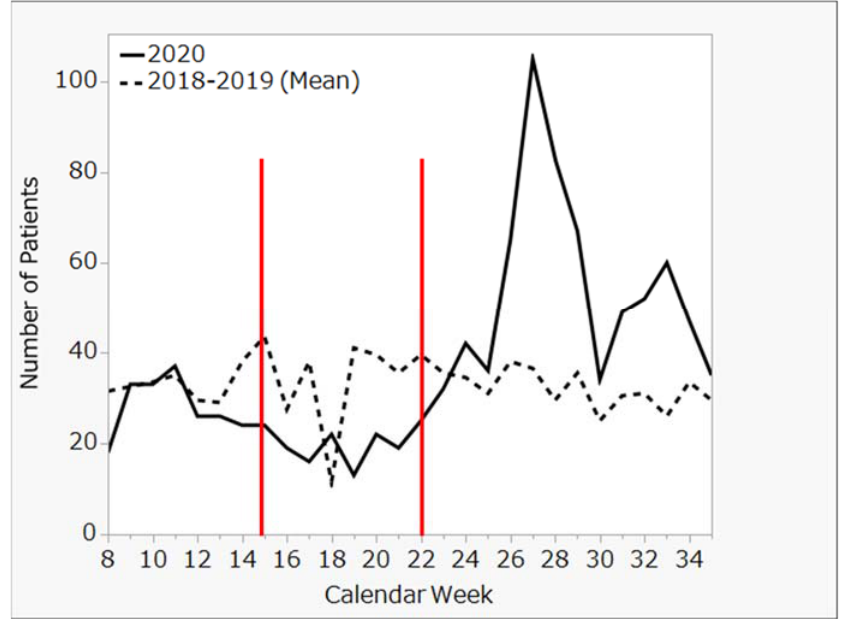
Figure 2. Trends in number of diabetes patients from outside Tokyo from 2018 through 2020.